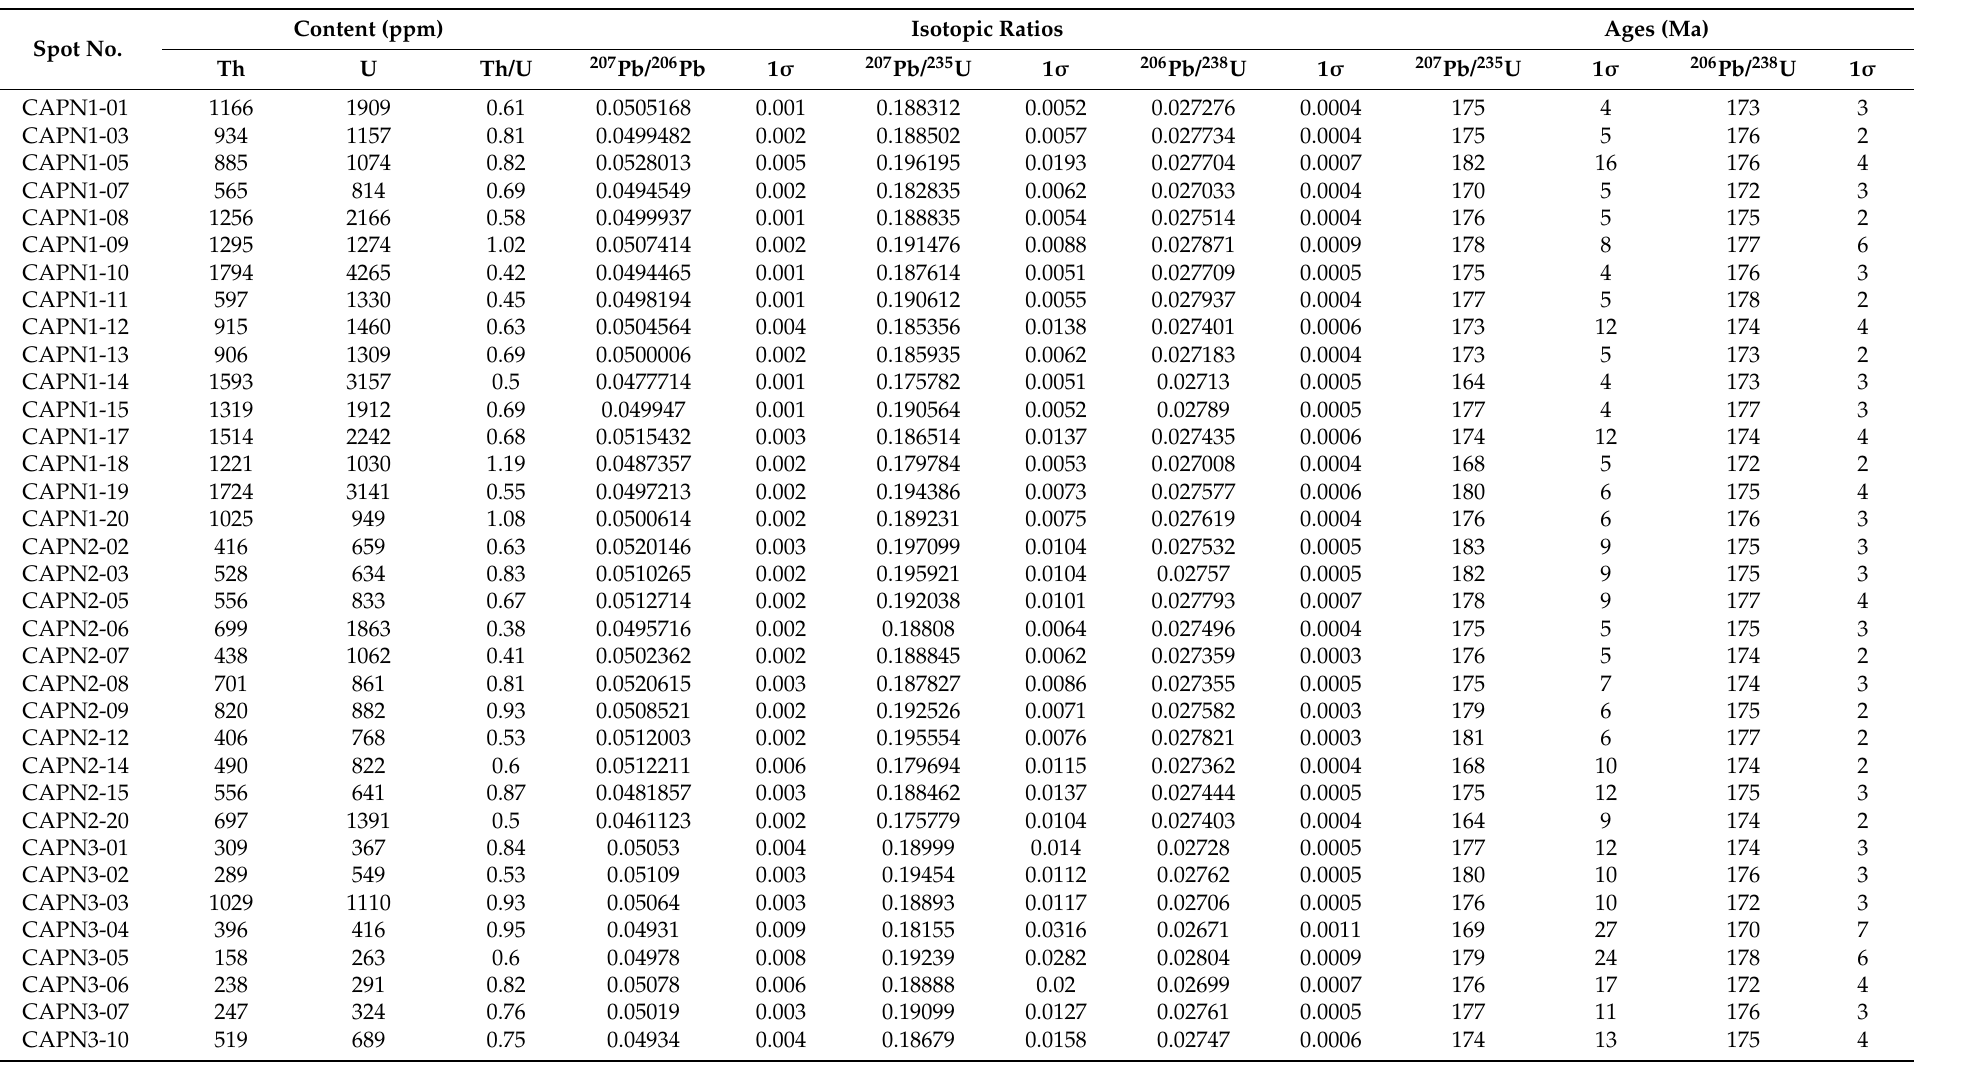
Table 3. Results of LA-ICPMS U–Pb dating for the single-grain zircon from the monzogranite. Spot